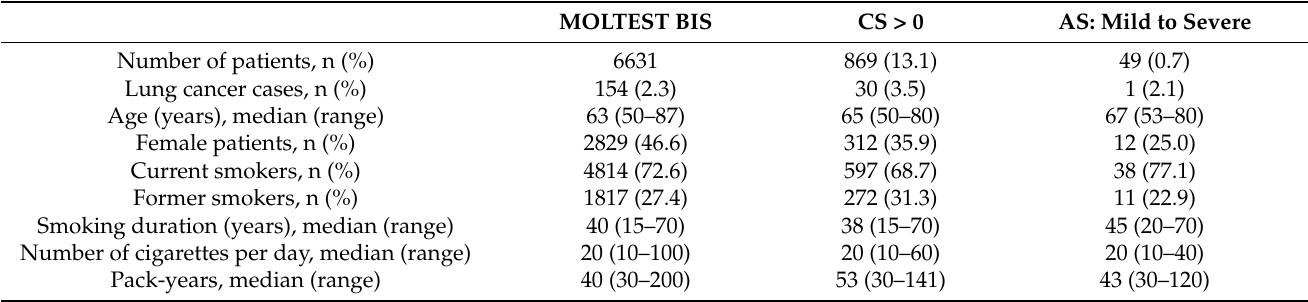
Table 1. Study population characteristics. CS—calcium score, AS—aortic stenosis. MOLTEST